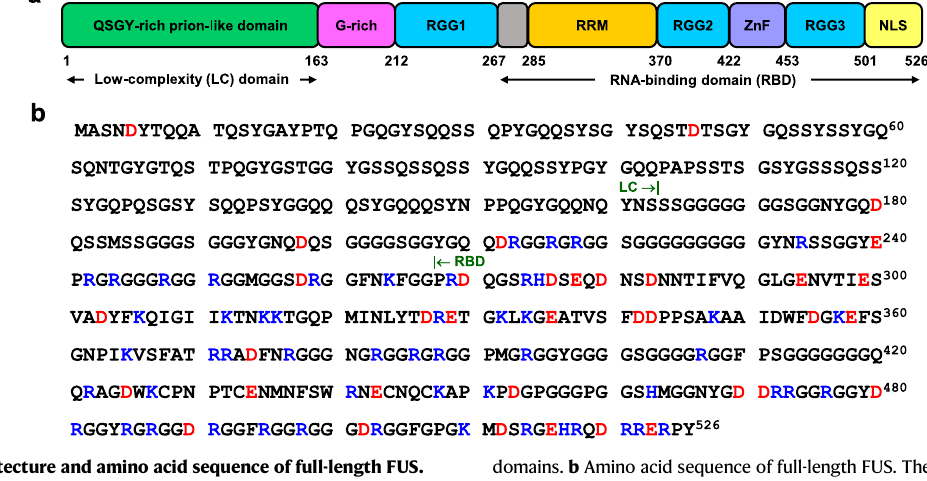
Fig. 2 | Domain architecture and amino acid sequence of full-length FUS. a Schematic representation of full-length FUS showing all the segments and